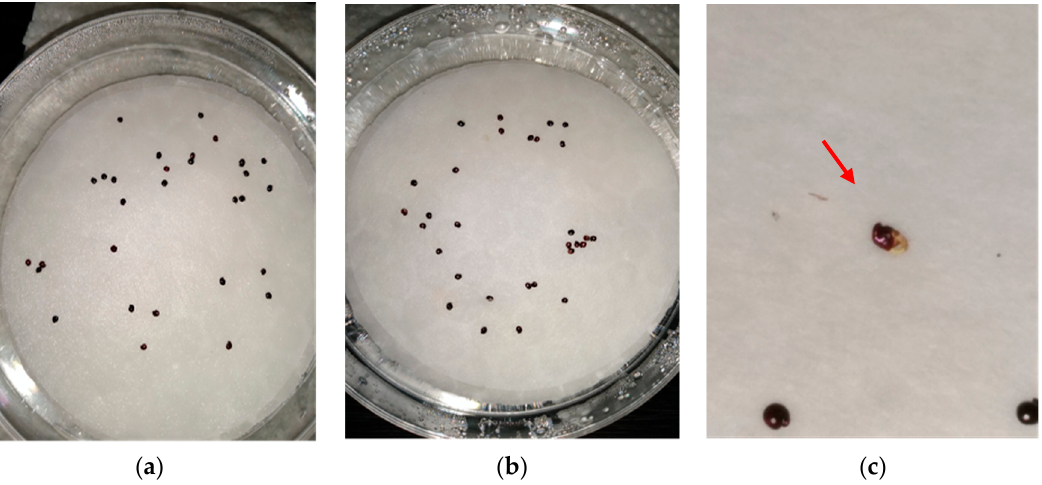
Figure 4. Photographs of preliminary germination (salinity) experiments with S. edulis. ( a , b ) seeds without immersion treatment ( c ) seeds with previous immersion for 24 h in distilled water.